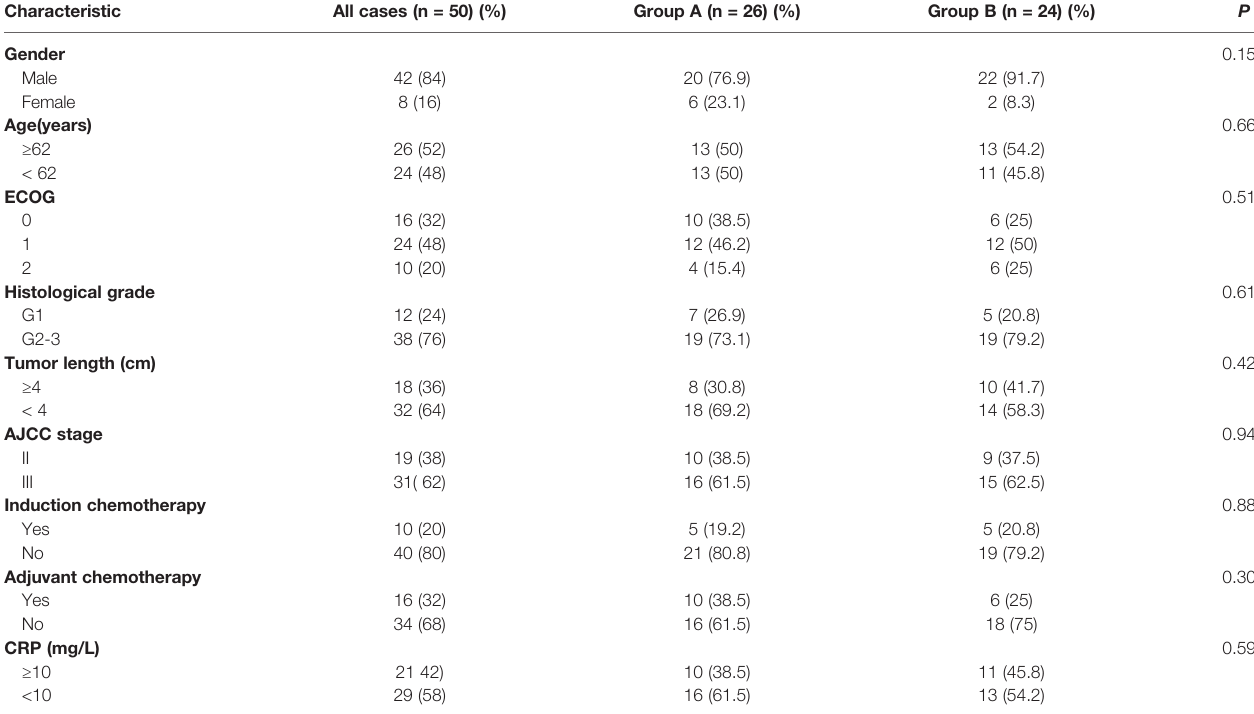
TABLE 1 | Characteristics of the patients at baseline.